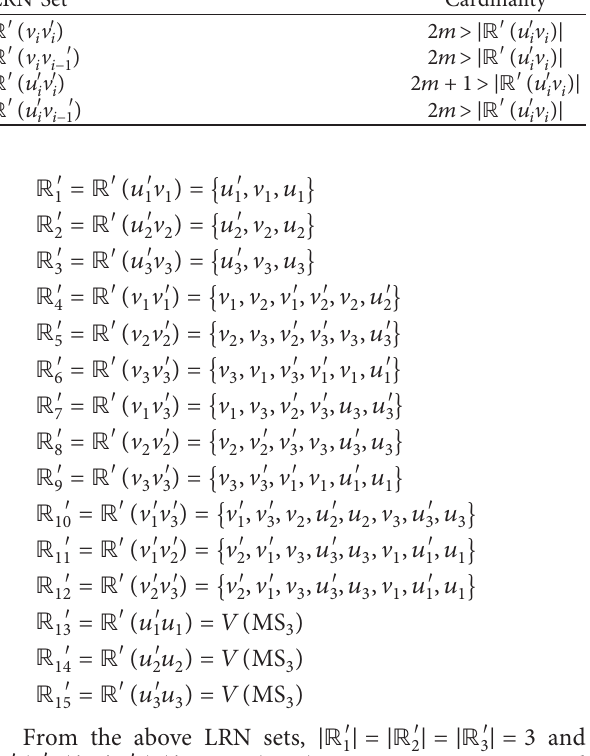
Table 1: Cardinality of each LRN set. LRN Set